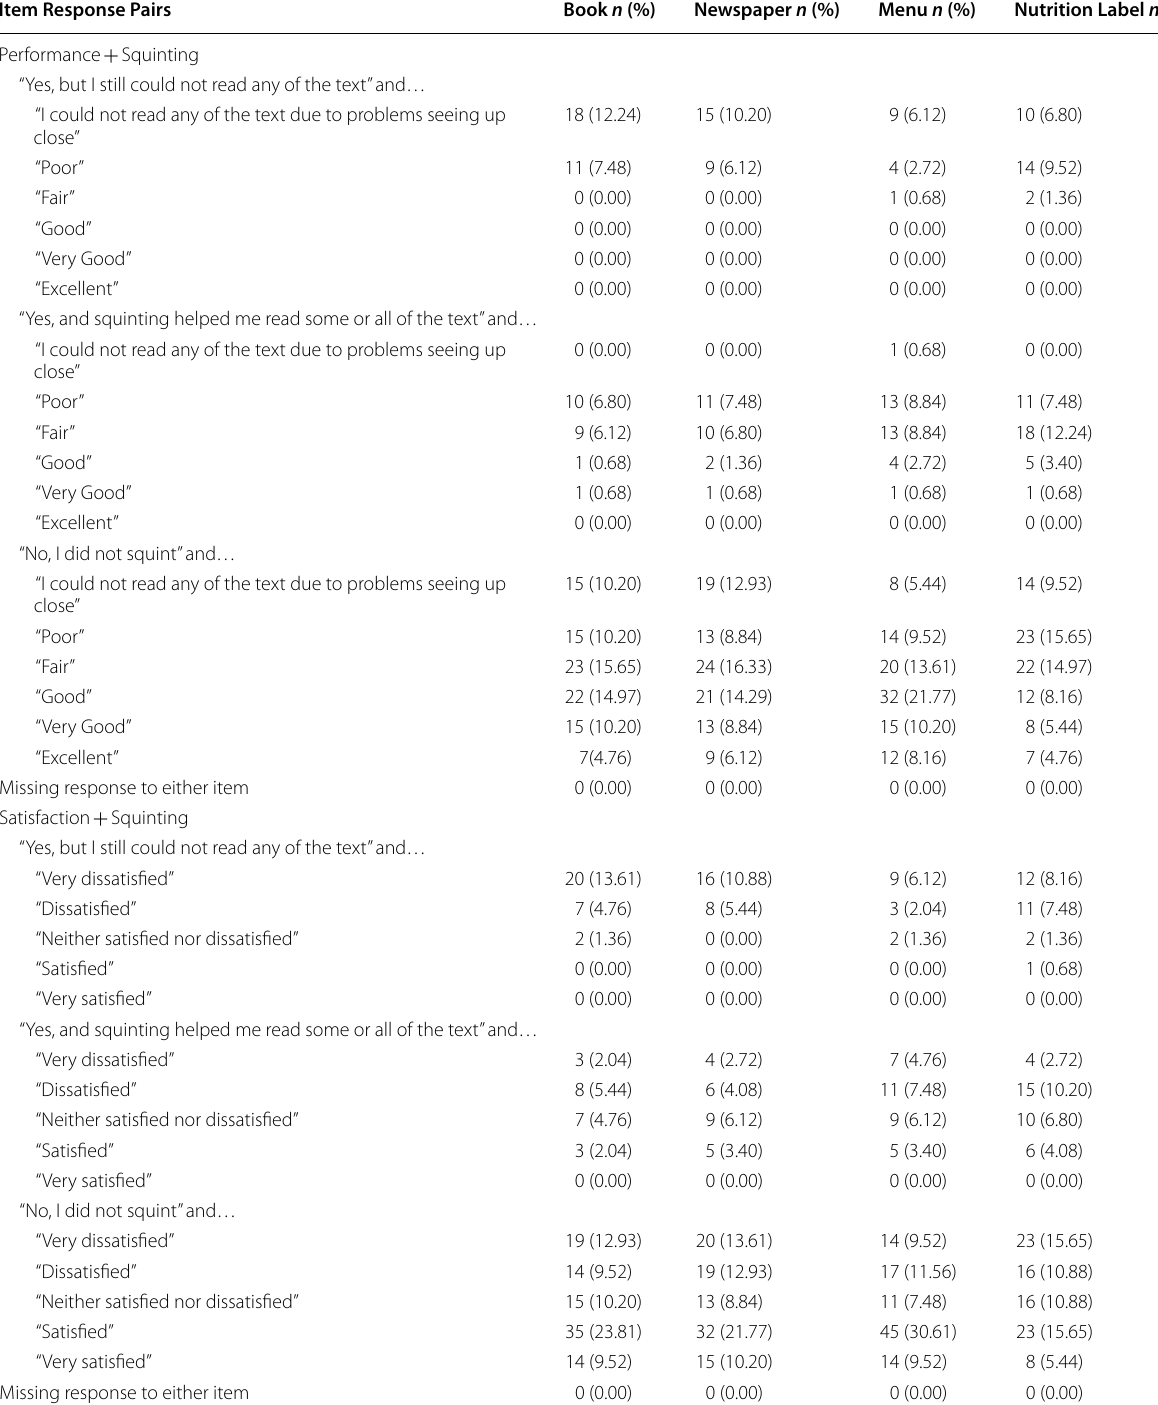
Squinting items and Satisfaction +